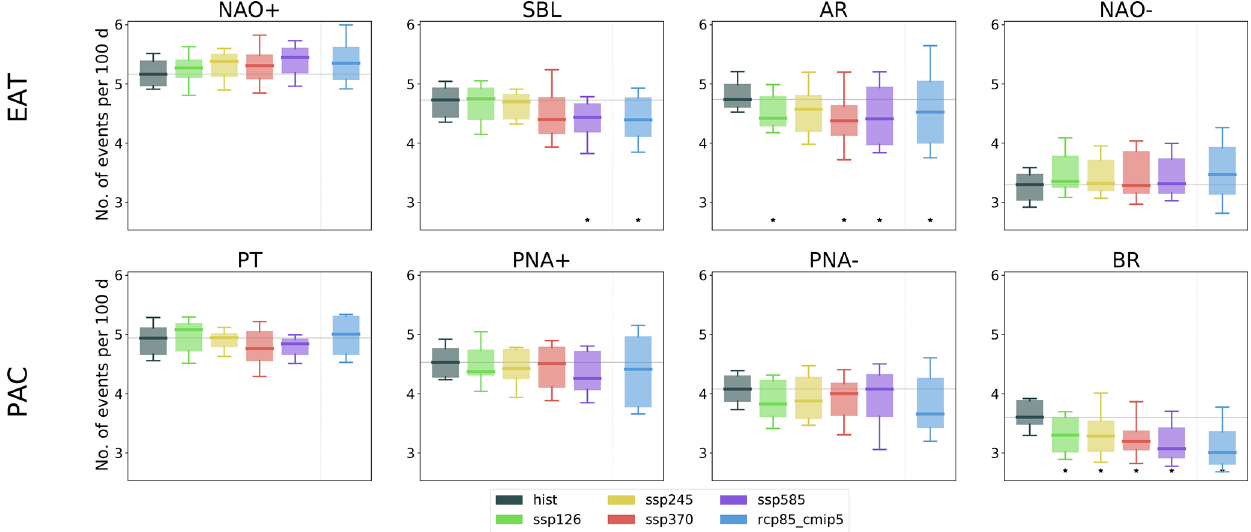
Figure 8. Number of regime events per 100d for the historical runs and future scenarios. Boxes are defined for the same periods as in Fig. 4, and the black stars at the bottom indicate significant variation with respect to the historical period.